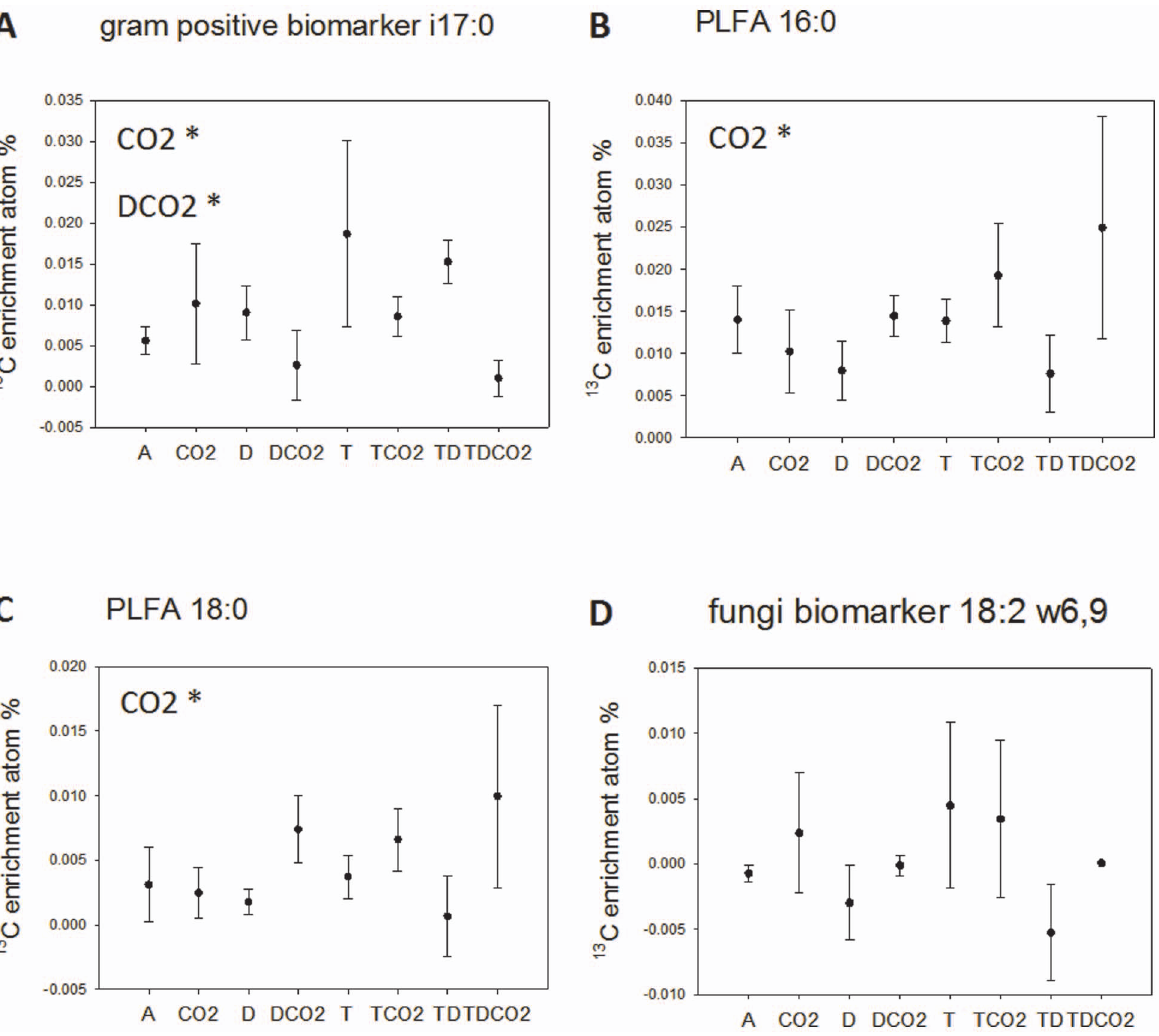
Figure 3. 13 C enrichment (atom%) in individual PLFAs. Gram positive biomarker i 17:0 ( A ), the non-specific PLFA 16:0 ( B ), the non-specific 18:0 ( C ) and the fungi biomarker PLFA 18:2 v 6,9 ( D ) one day after addition of 13 C 2 -glycine to field plots subjected to in situ treatment through one year with the climate change factors: elevated atmospheric CO 2 concentration (CO2), summer drought (D) and warming (T), and those treatments in all combinations. A is ambient control=no treatment. Error bars represent standard error. Significant effects of treatments: * is P ,